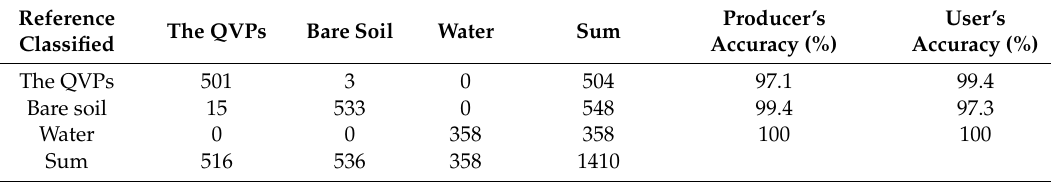
Confusion matrix showing the producer’s and user’s classification accuracies for three land cover classes obtained from the selected predictive variable datasets of the combined March–May–July–October–December